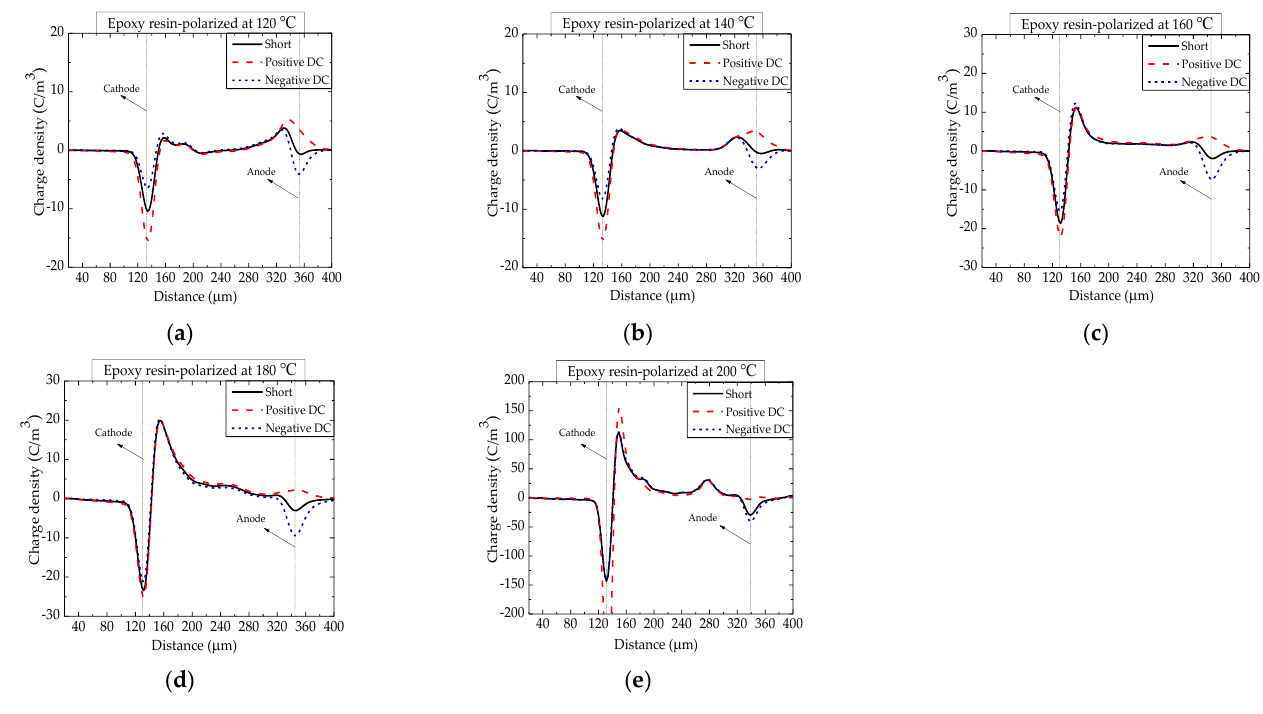
Figure 3. Space charge distribution in epoxy resin polarized at temperatures between 120 and 200 °C. ( a ) 120 °C; ( b ) 140 °C; ( c ) 160 °C; ( d ) 180 °C and ( e ) 200 °C. The space charge distributions in epoxy/nano − SiO 2 /micro − BN composites polarized at temperatures from 40 to 200 °C are shown in Figures 4 and 5. The space charge distri- bution and its dependence on temperature are very complicated due to the coexistence of homopolar and heterogenous charges [22]. Compared with epoxy resin, the density of heterocharges in the epoxy composite was smaller above 60 °C. Furthermore, the glass transition temperature ( T g ) of epoxy resin and the composite is between 100 and 120 °C, and the increase in heterocharges becomes much less significant when the temperature is above 100 °C. The homocharges injected by the electrode are just hidden by heterocharges above 120 °C [23].